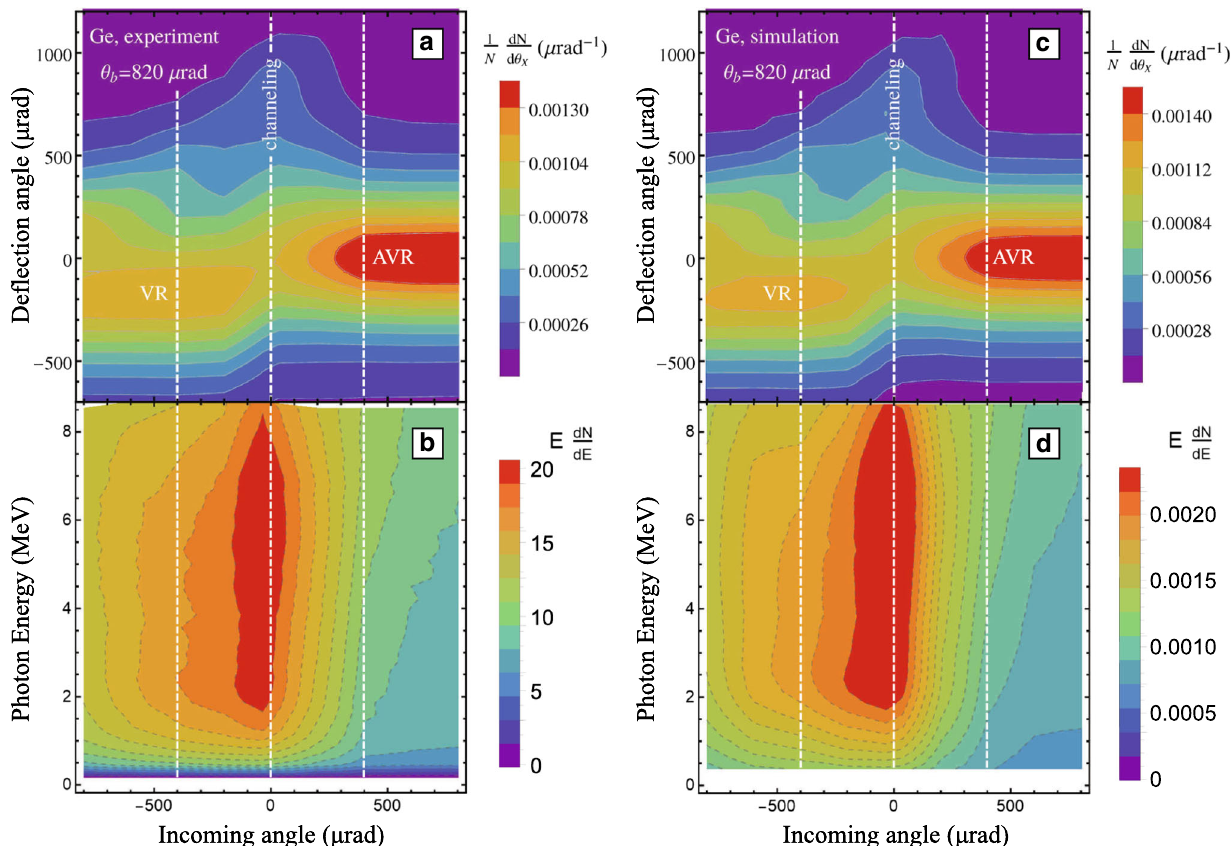
Fig. 3 Experimental (left) and simulated (right) deflection angle distributions (top) and radiation spectral intensities (bottom) with respect to the alignment of the Ge bent crystal with bending angle of 820 µ